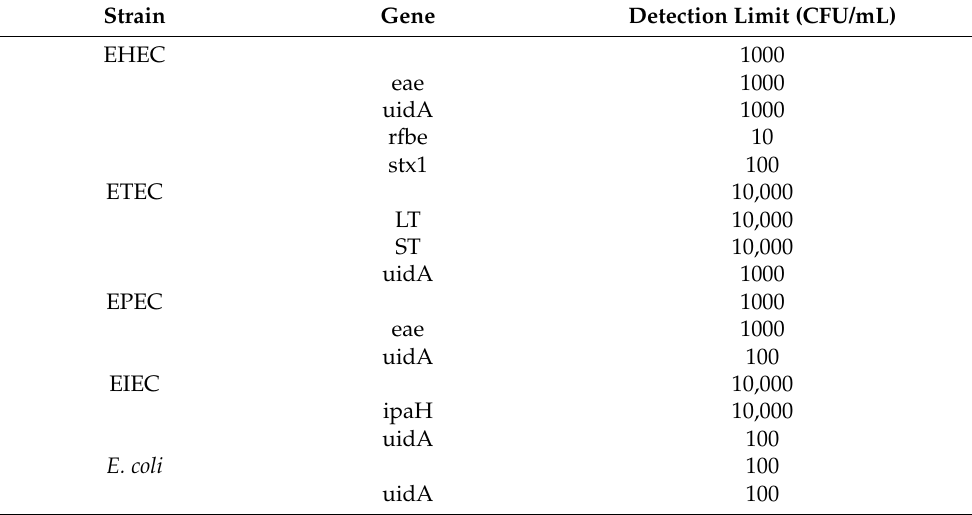
Table 3. Limit of detection for each Bacteria